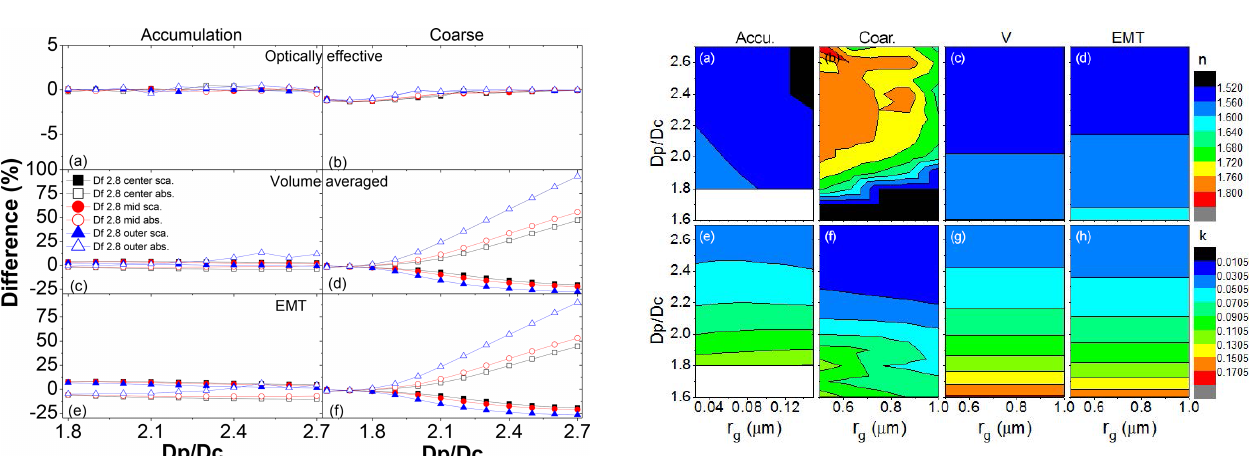
Figure 5. The relative differences of scattering and absorption cross sections of black carbon aggregates coated by sulfate (BC frac- tal dimension of 2.8) induced by their optically effective complex refractive indices ( a and b ), and refractive indices based on the volume-weighted average method ( c and d ) and Bruggeman ef- fective medium theory ( e and f ) as a function of shell / core ratio ( D p /D c ), in accumulation ( a , c and e ) and coarse ( b , d and f ) modes, respectively. Three BC coating morphologies are consid- ered, i.e., a core shell with the BC mass center located at the par- ticle geometric center (black squares) and two off-center core-shell structures including BC aggregates lying in the middle position of a particle radius (red circles) and the outer position close to the spher- ical boundary (blue triangles). Solid symbols denote scattering co- efficients, while open interiors indicate absorption coefficients.